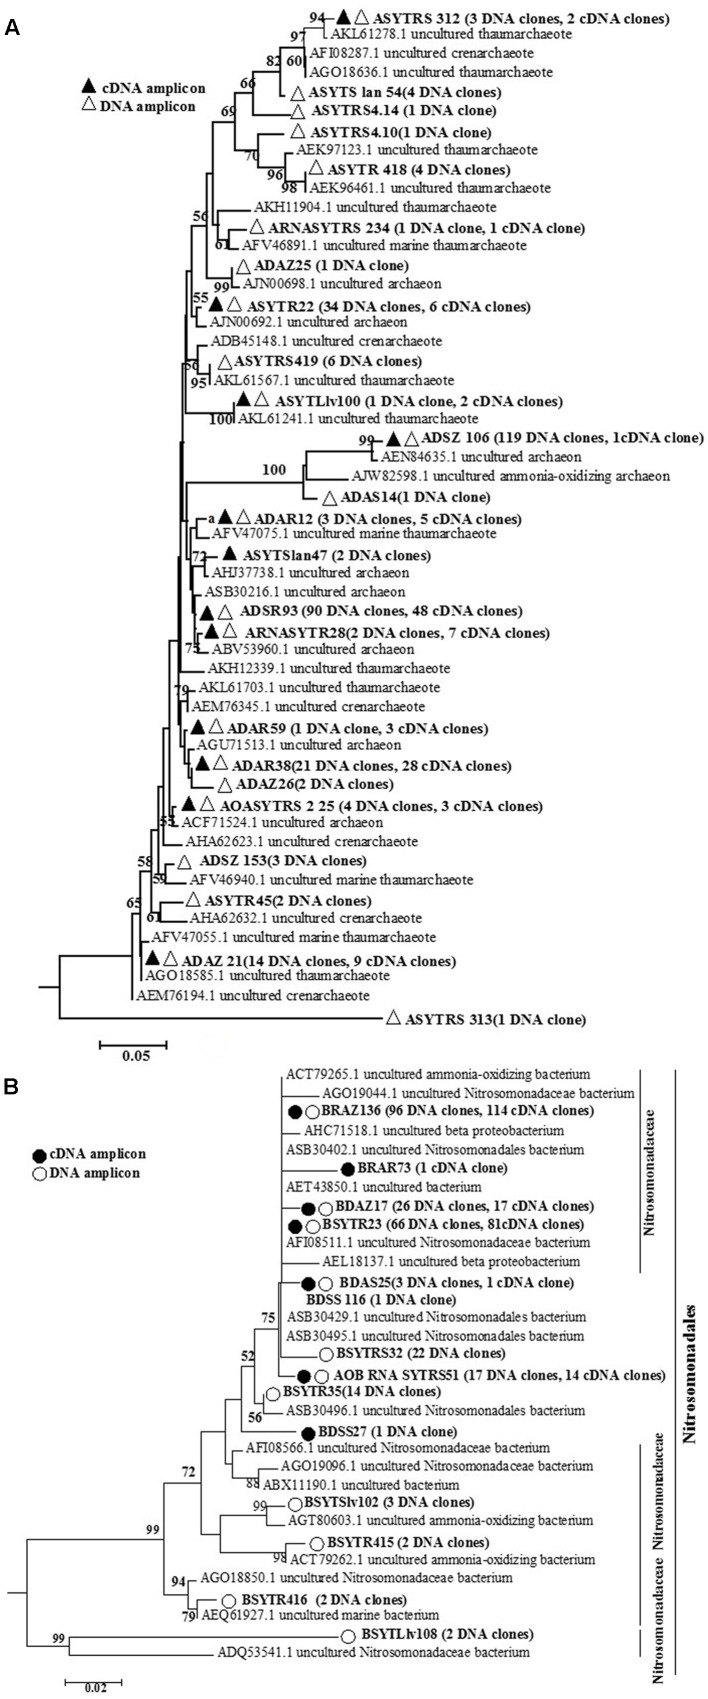
Phylogenetic tree constructed using distance and neighbor-joining method for archaeal amoA sequences (A) and bacterial amoA gene sequences (B) translated from cloned archaeal amoA and bacterial amoA gene sequences at the DNA and transcript levels, as recovered from the seagrass Thalassia hemprichii and their closest matches in GenBank from DNA samples and cDNA samples. Bootstrap values greater than 50% of 100 resamplings are shown near the nodes.